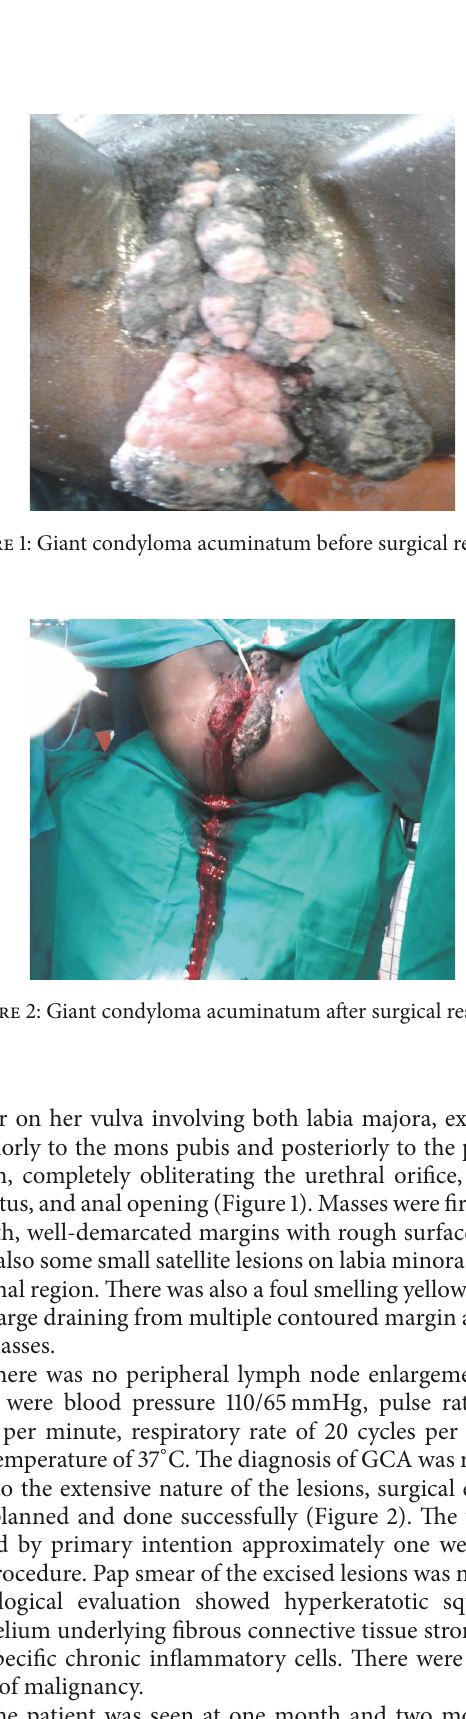
colour on her vulva involving both labia majora, extending anteriorly to the mons pubis and posteriorly to the perianal region, completely obliterating the urethral orifice, vaginal introitus, and anal opening (Figure 1). Masses were firm, edge growth, well-demarcated margins with rough surface. There were also some small satellite lesions on labia minora and the perianal region. There was also a foul smelling yellow vaginal discharge draining from multiple contoured margin areas on the